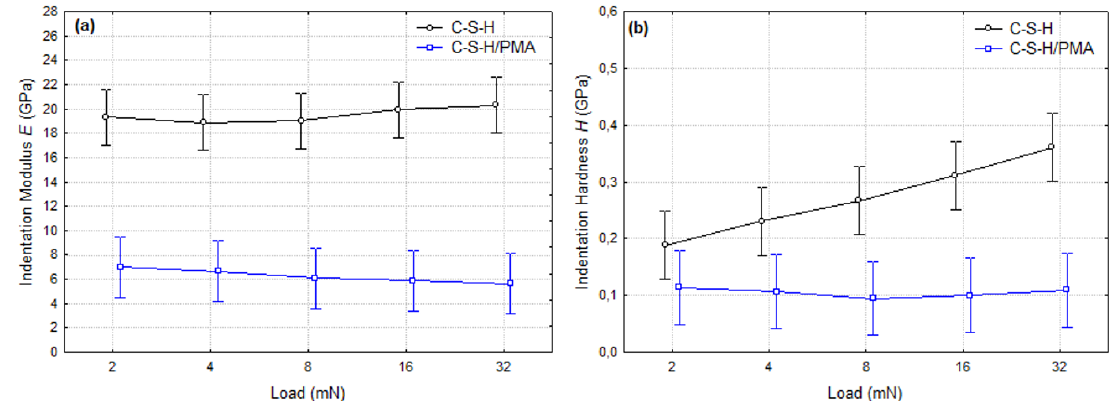
Figure 5. Elastic modulus - E (a) and hardness - H (b) vs applied load - P of C-S-H and C-S-H/PMA until 32 mN (matrix 1).